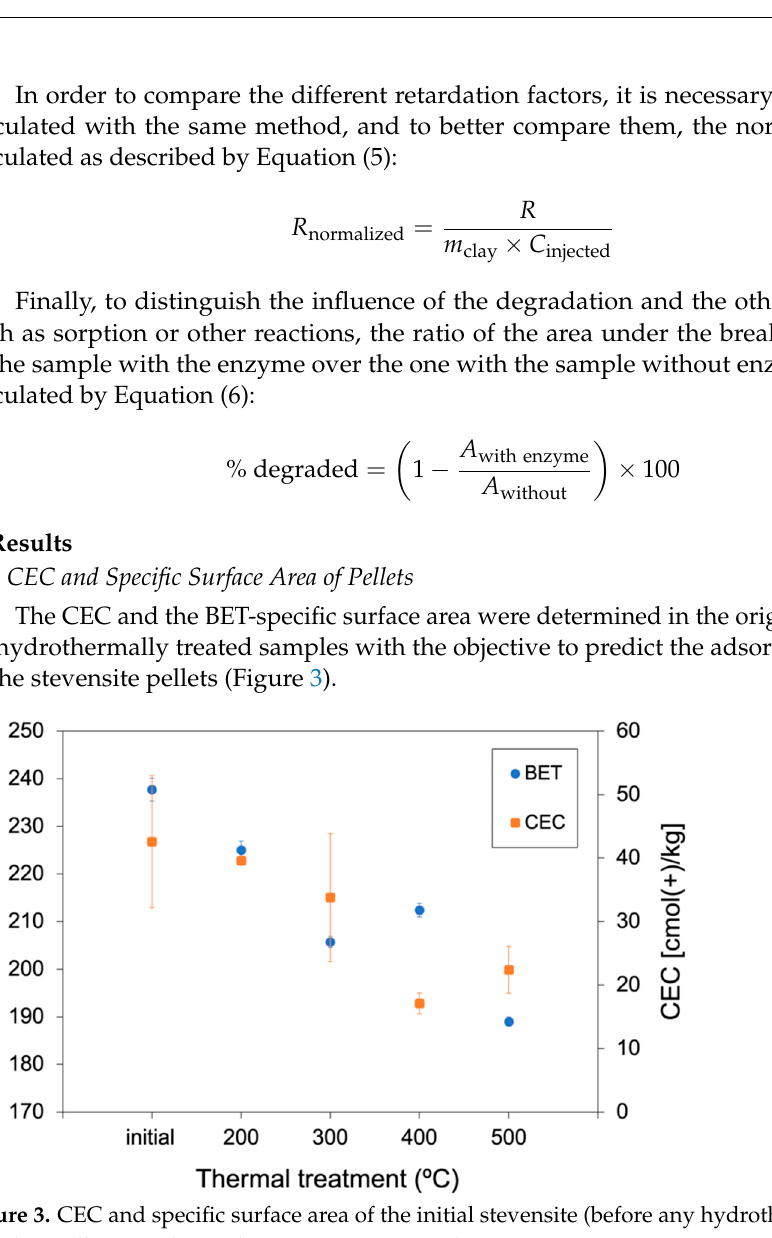
Figure 3. CEC and specific surface area of the initial stevensite (before any hydrothermal treatment) and thermally treated samples at 200, 300, 400 and 500